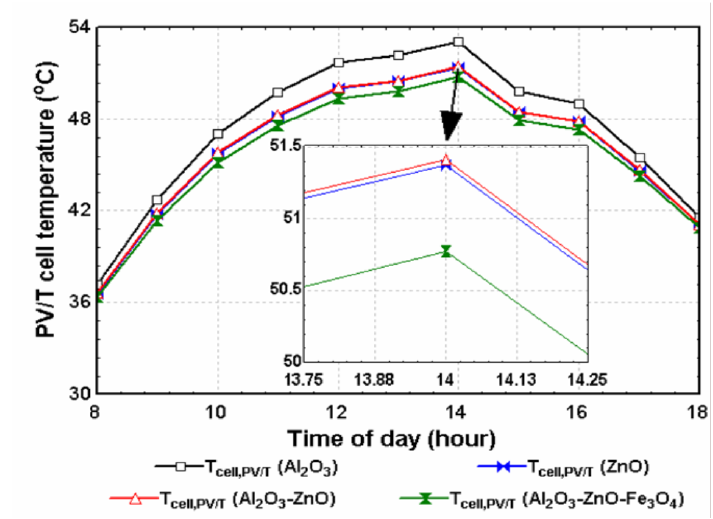
Figure 9. Numerical result of PV/T cell temperature.